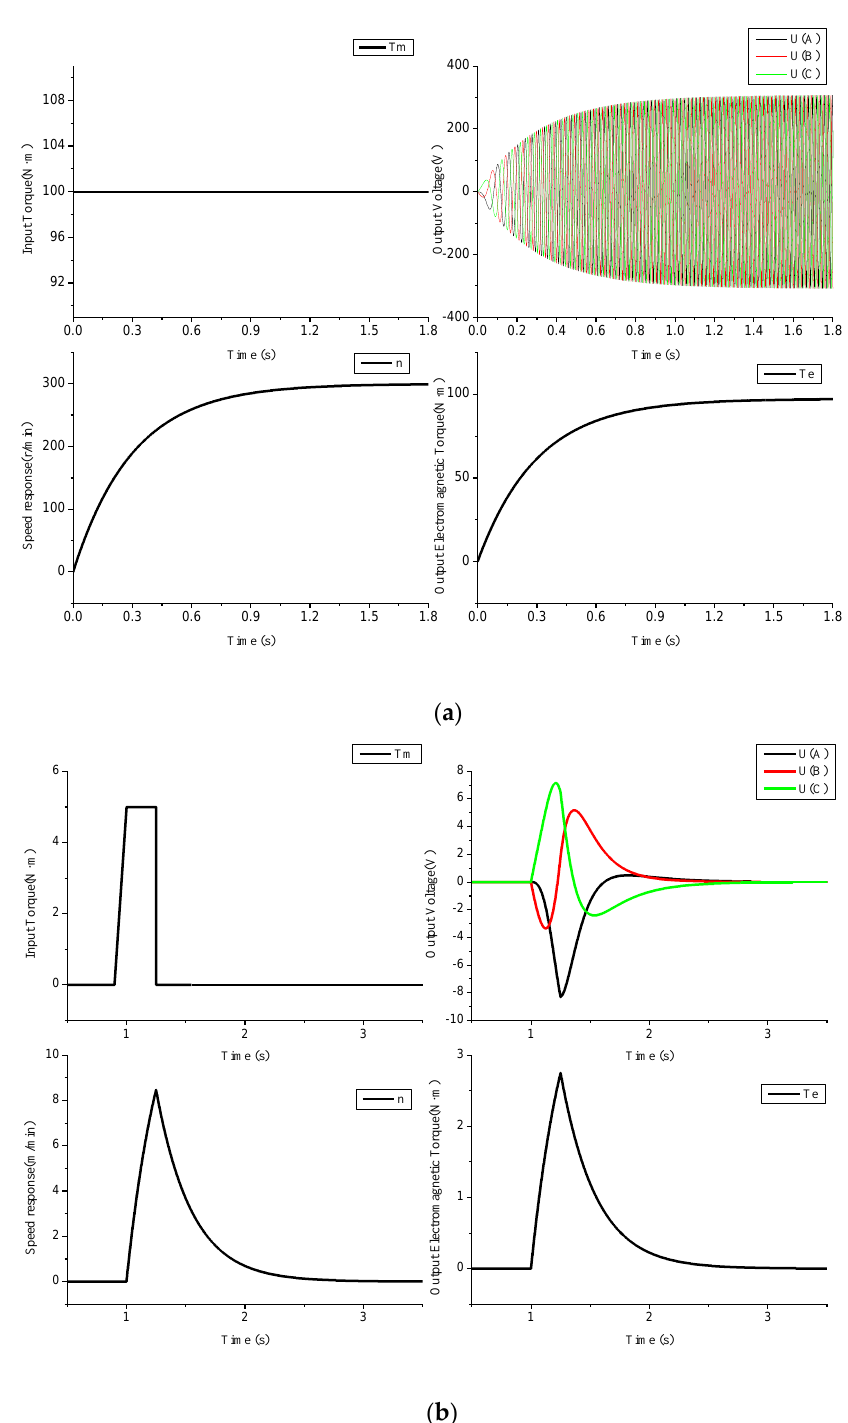
Figure 7. Output performance of starting and input disturbance. ( a ) Start with constant torque input; ( b ) dynamic performance with step torque input.